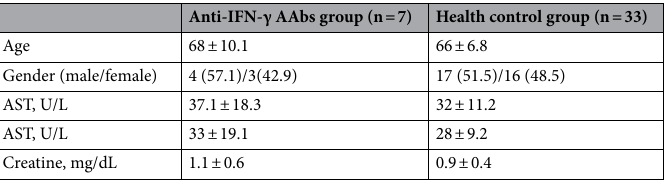
Table 1. Clinical variables between the Anti-IFN-γ AAbs and health control groups. Data are summarized as mean ± SD or n